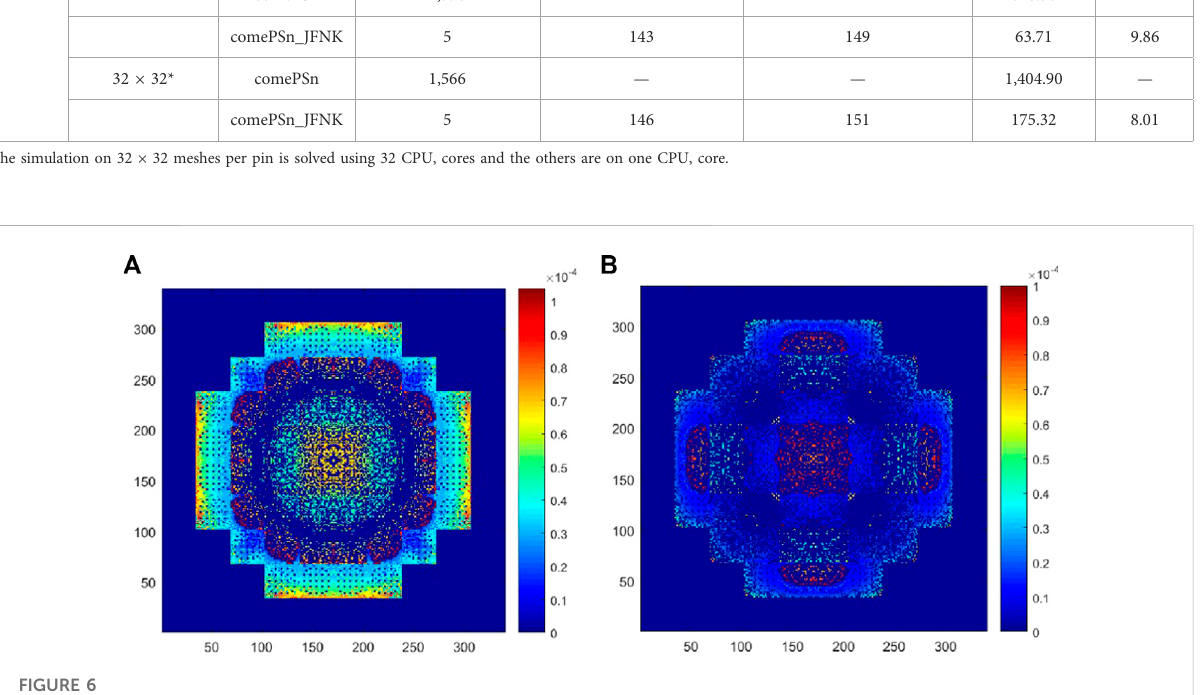
The restarted GMRES (Generalized Minimal REsidual) method (Saad and Schultz, 1986) is adopted to solve Eq. 15 and the maximum Krylov subspace dimension is set to 20. At last, the global convergent